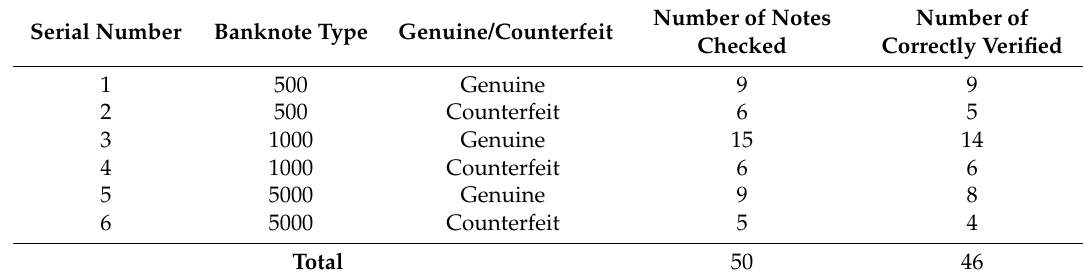
Table 6. Verification